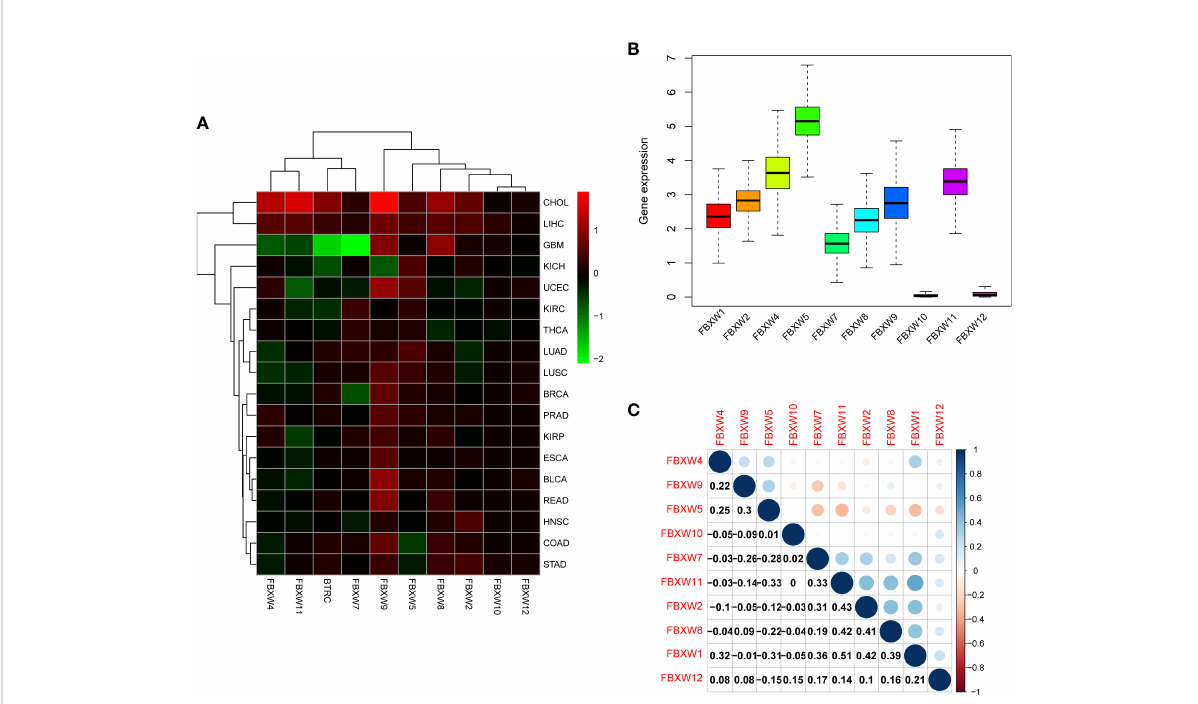
FIGURE 3 FBXW family gene expression levels and correlation in different cancer types from TCGA. (A) Heatmap showing the difference of FBXW family gene expression in 18 cancer types from TCGA database. The red and green indicate the high or low expression, respectively. (B) Boxplot illustrating the distribution of FBXW family gene expression in various cancers. (C) The correlation between FBXW family genes. The blue dot indicated the positive correlation. The red dot indicated the negative